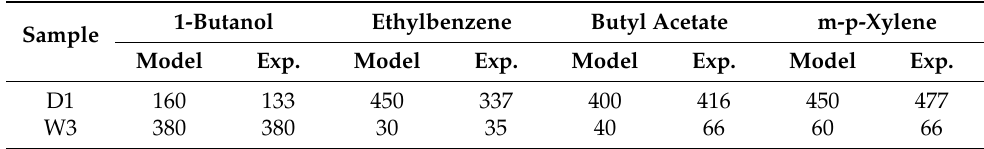
Table 13. Comparing the C 480 h ( µ g/m 3 ) observed from the emission profiles by the model (17) and experimental values of four selected VOCs emitted from samples D1 tested in t = 29 ◦ C and